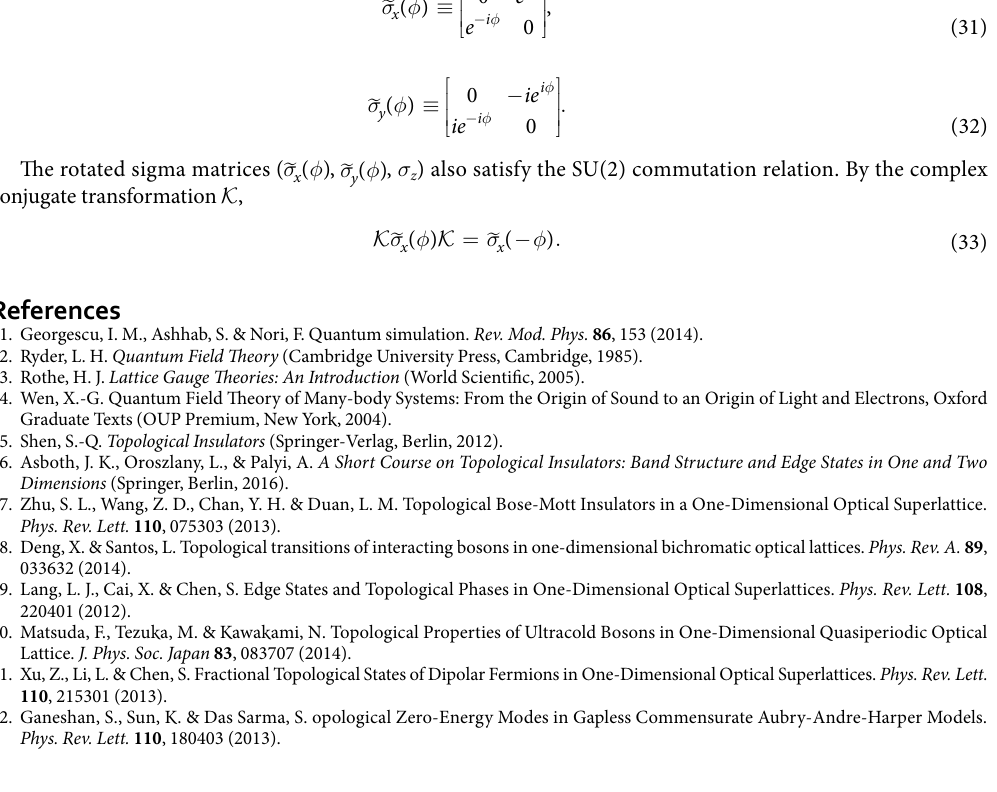
aa jj and + 1 ba jj ba jj and Λ . Both cases create the + − 1 1